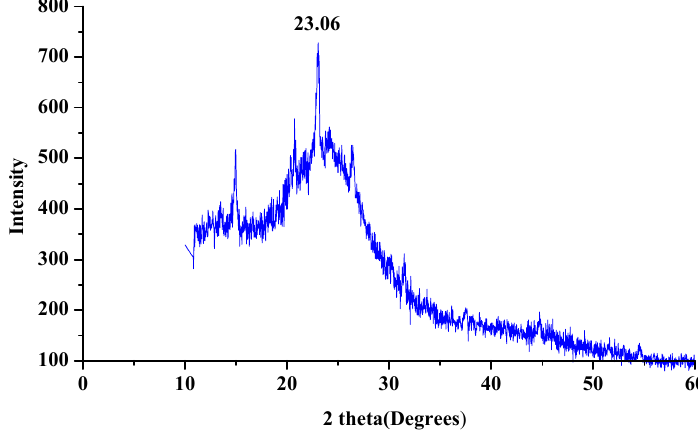
Figure 8. XRD patterns of the Figure 8. XRD pa tt erns of the TSAC.